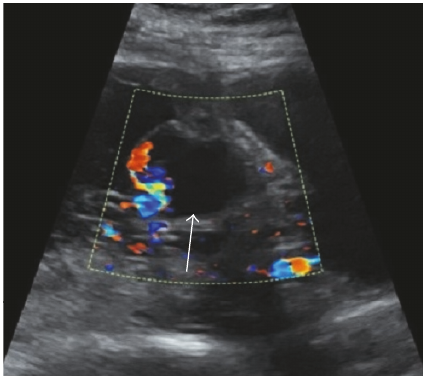
Figure 7: Postprocedure ultrasound the next morning demonstrates significantly reduced flow within the pseudoaneurysm